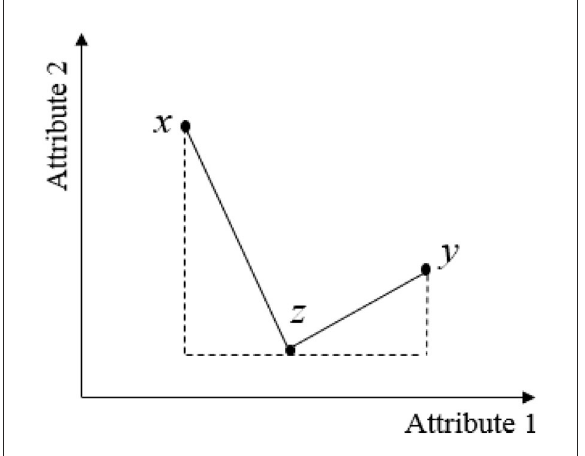
FIGURE1 Decoy effect from the perspective of loss